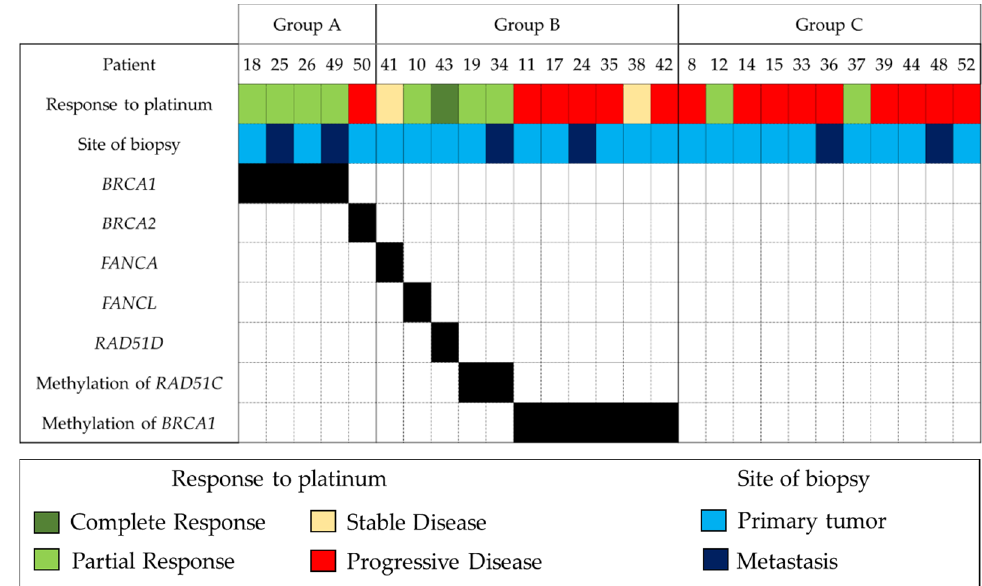
Figure 2. Progression-free ( a ) and overall ( b ) survivals of patients challenged with platinum-based chemotherapy, according to molecular status.